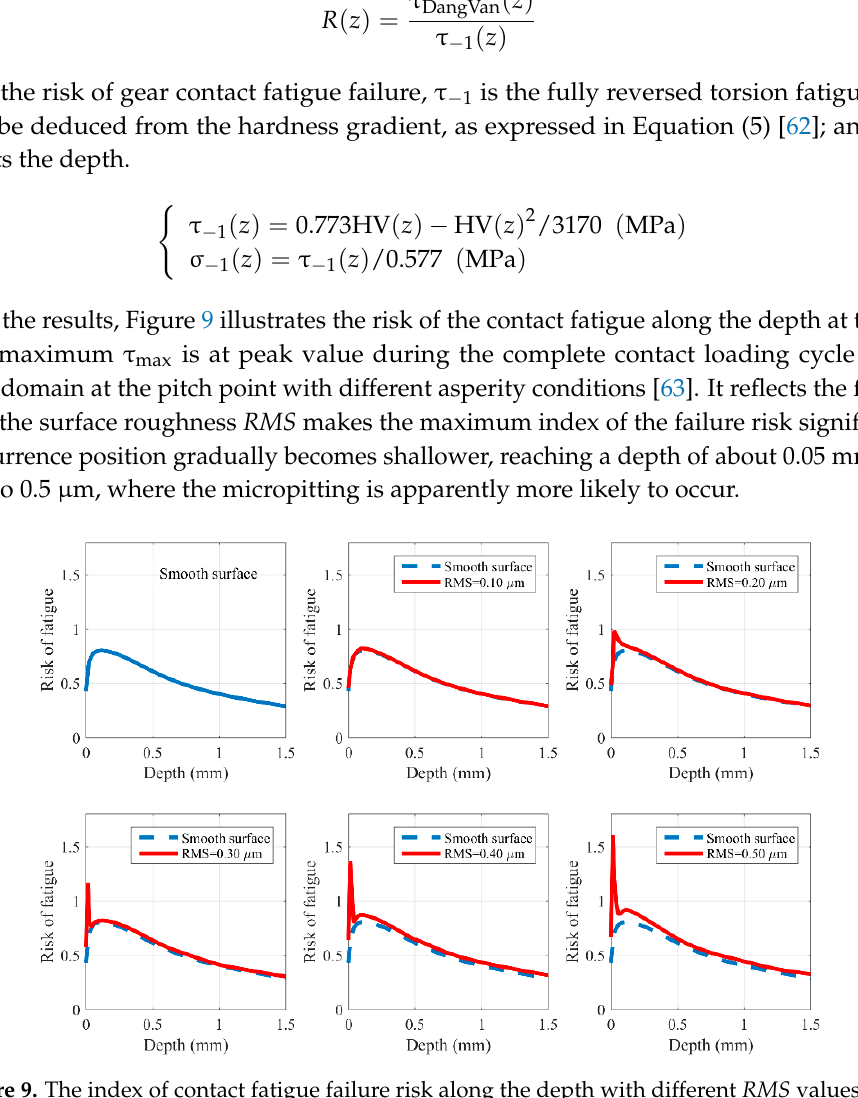
Figure 9. The index of contact fatigue failure risk along the depth with different RMS values [63].